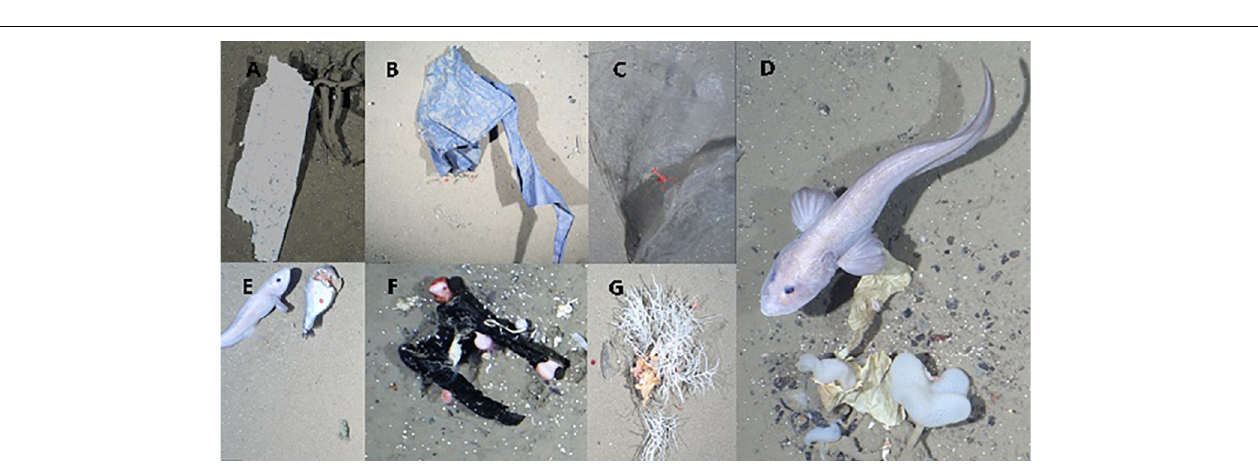
FIGURE 4 | Examples of marine litter photographed by OFOS at HAUSGARTEN: (A) Styrofoam lying on Caulophacus debris, (B) plastic film in contact with two Bythocaris shrimps, (C) Bythocaris sp. resting on plastic bag, (D) plastic wrapping material entangled in C. arcticus and colonized by B. margaritacea , (E)